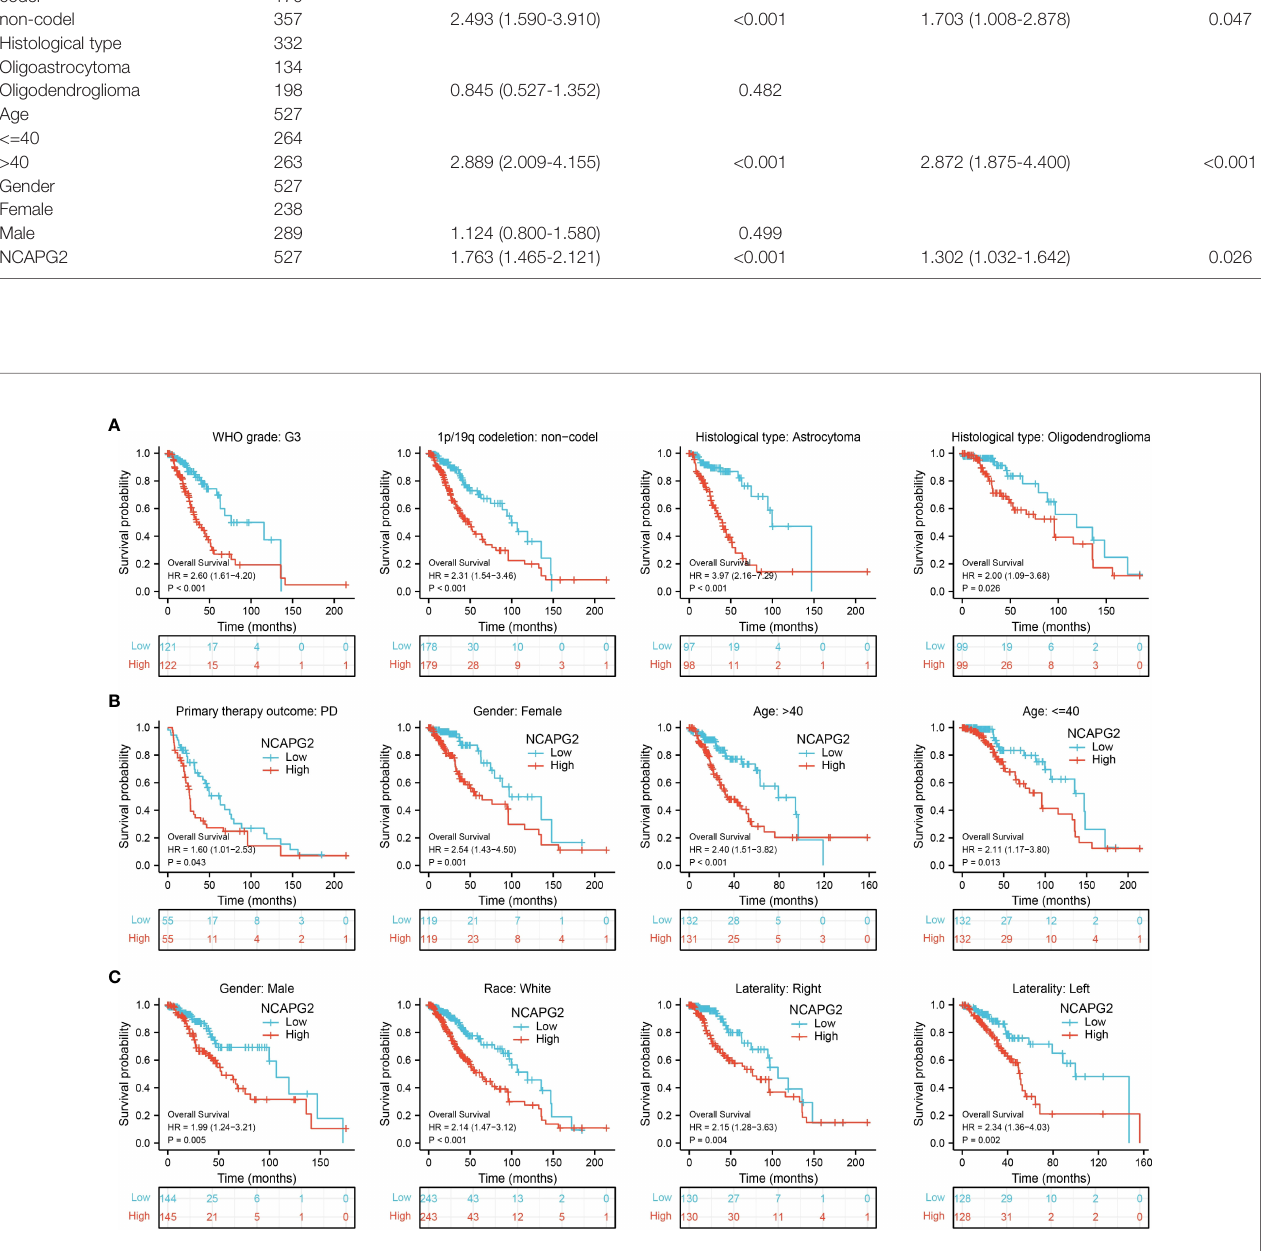
FIGURE 5 | Associations between NCAPG2 expression level and the overall survival in different clinical subgroups of LGG in the TCGA database. (A – C) including the WHO grade 3, 1p/19q non-codeletion, astrocytoma, Oligodendroglioma, subgroup of PD, Male, Female, age >40, age <40, Race, white, Lateralty, right and